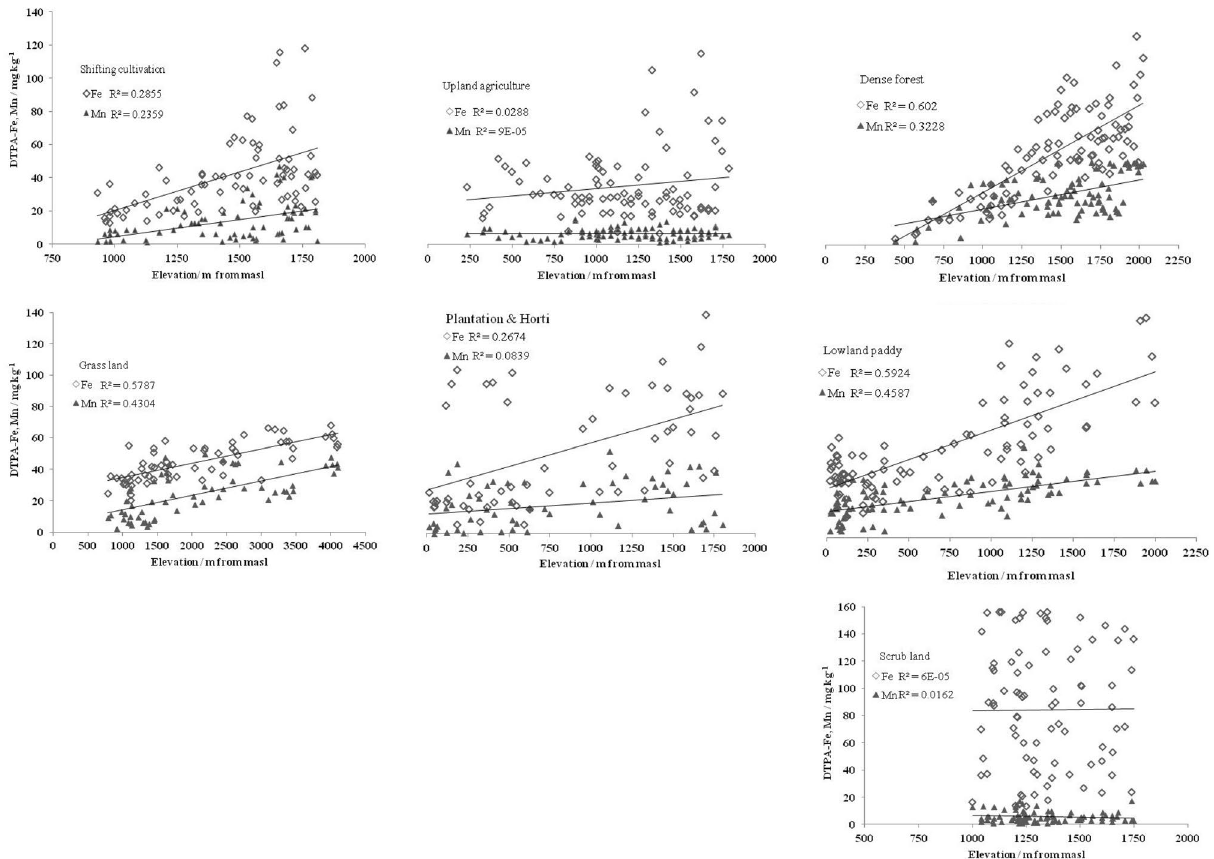
Figure 4. Effect of land uses on response of DTPA extractable Fe and Mn (mg kg -1 ) concentrations along the altitudinal